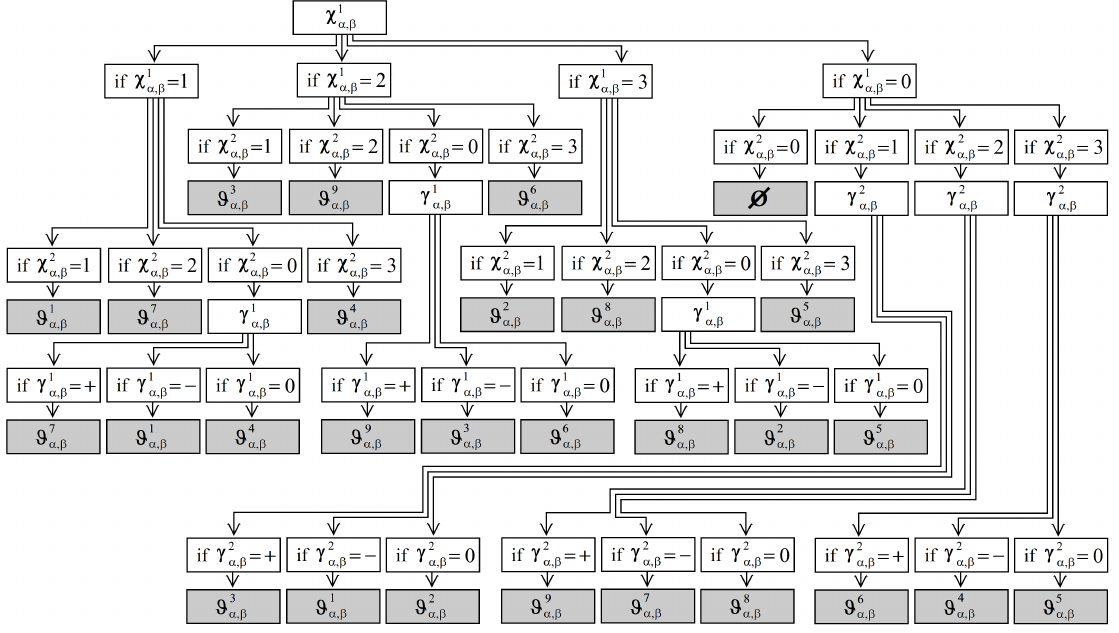
Figure 3. The obtained decision tree using the